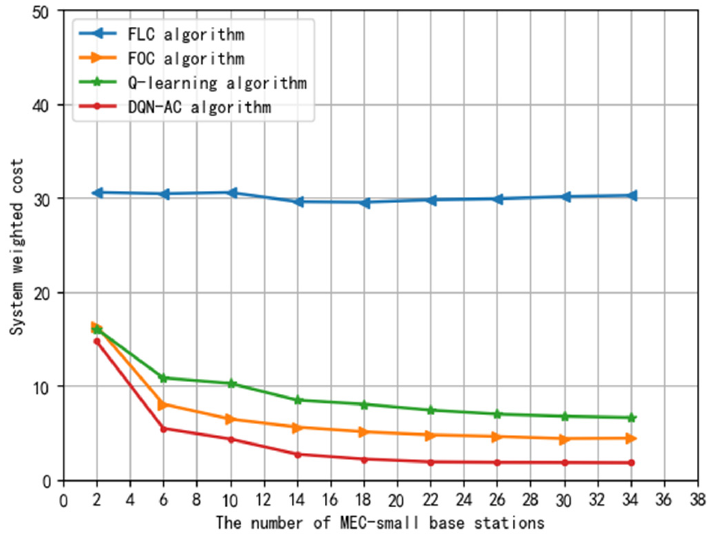
Figure 3. The impact of the number of MEC small base stations on system weighted cost.